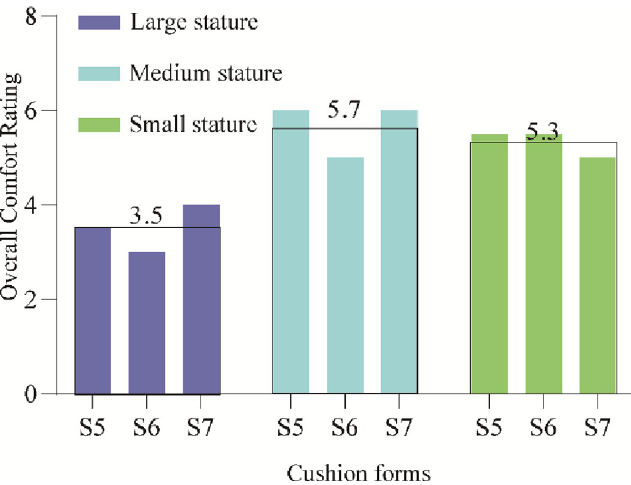
Fig 12. Histogram of average flat cushion comfort scores for three kinds of